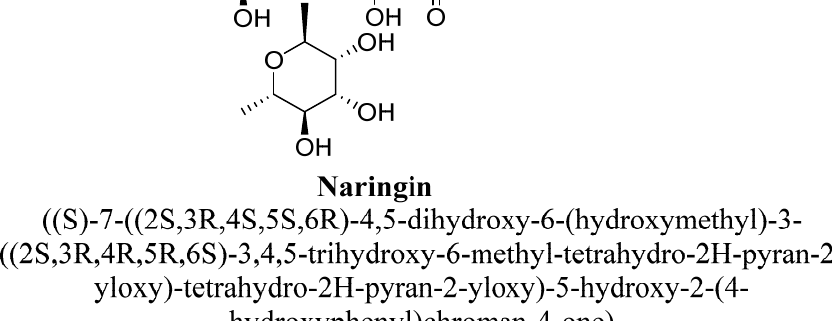
Figure 36. Naringin. SAR of Flavanones